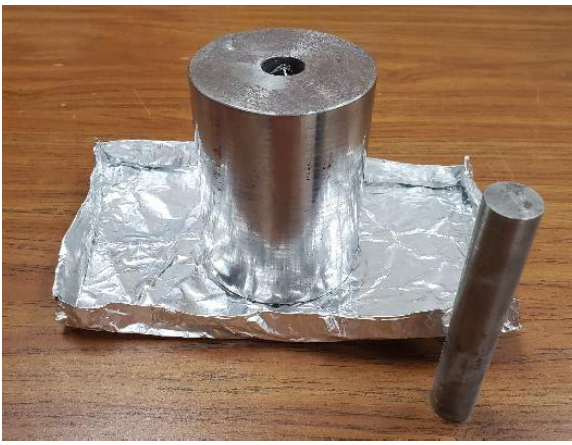
Figure 5. Preheated die filled with pellets.